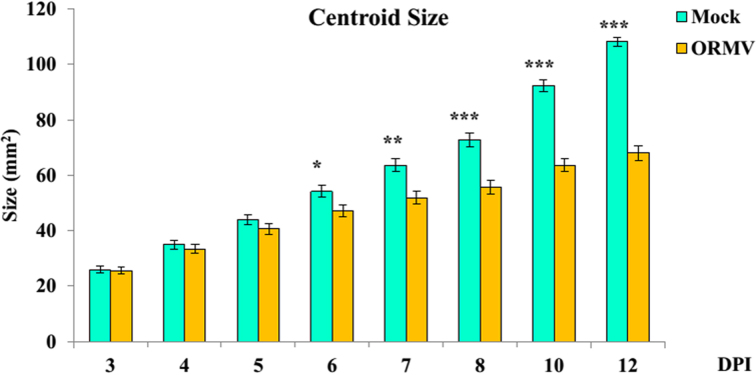
Mean centroid size for mock- and ORMV-inoculated plants across the experiment. Error bars indicate +/- standard error. * = P < 0.05; ** = P < 0.01; *** = P < 0.0001, Mann-Whitney tests.